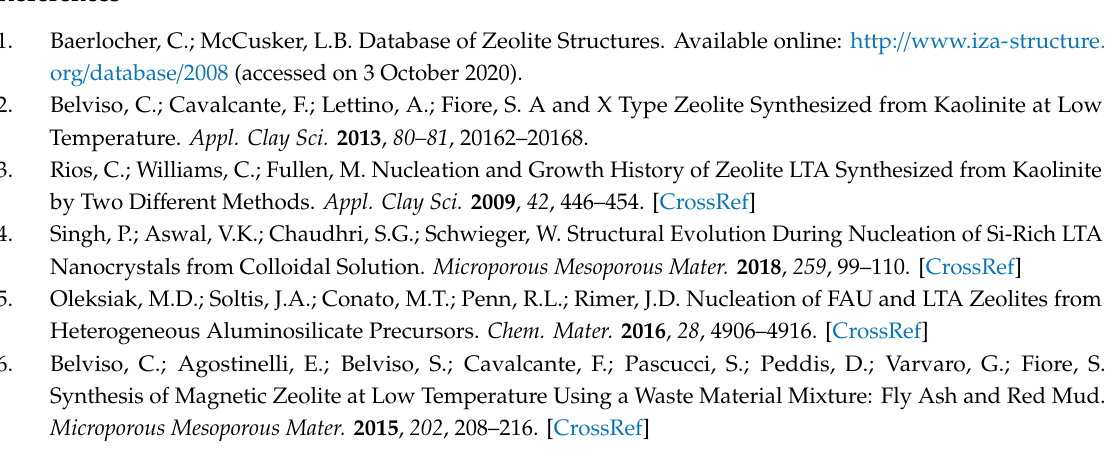
Figure S1: X-ray di ff raction profiles of LN 2w-40 and calculated EMT